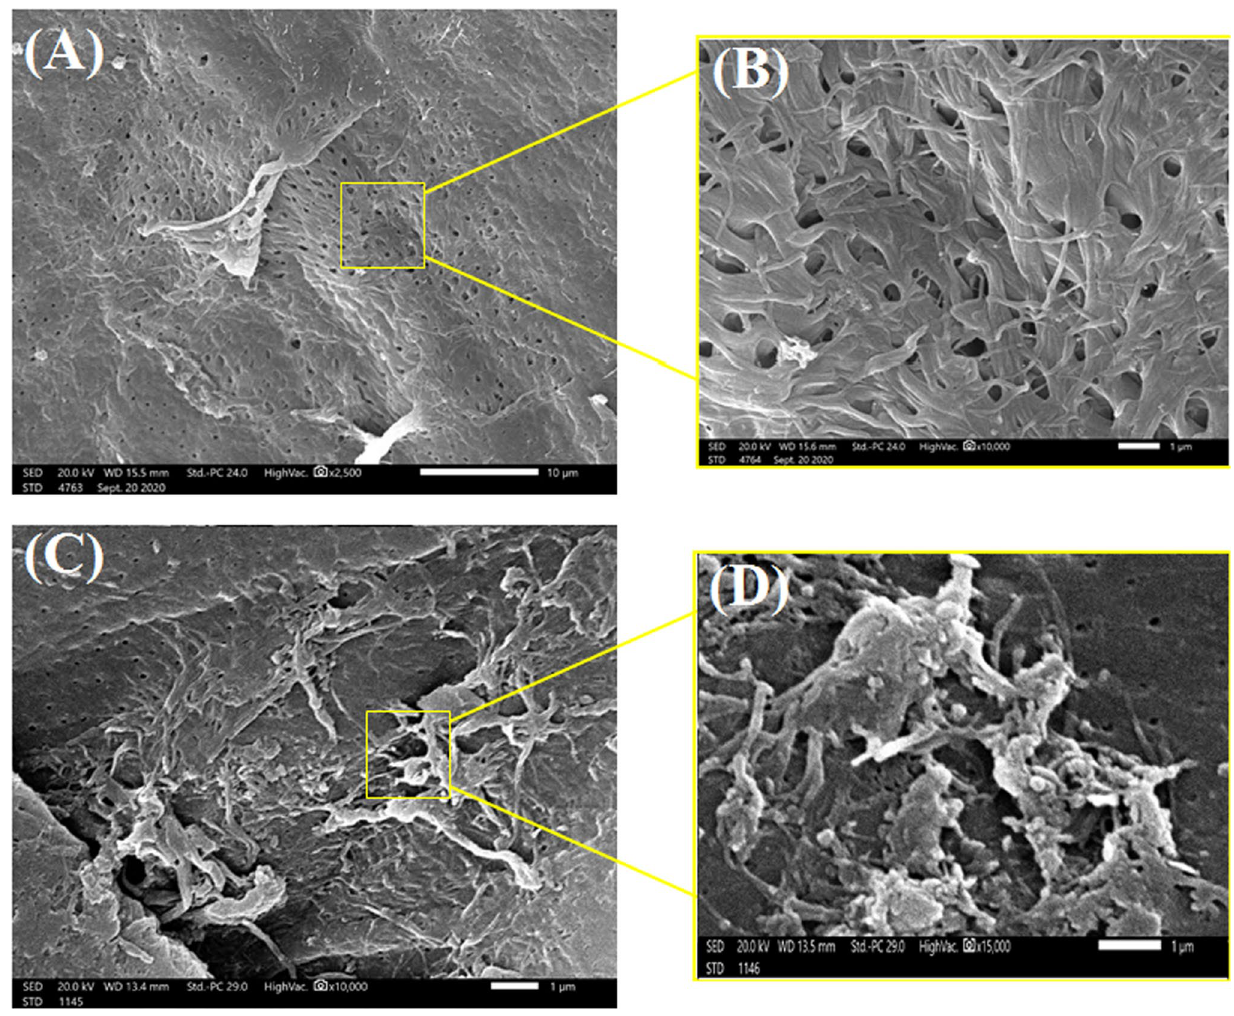
Fig. 2 SEM of A, B AmCs and C, D α